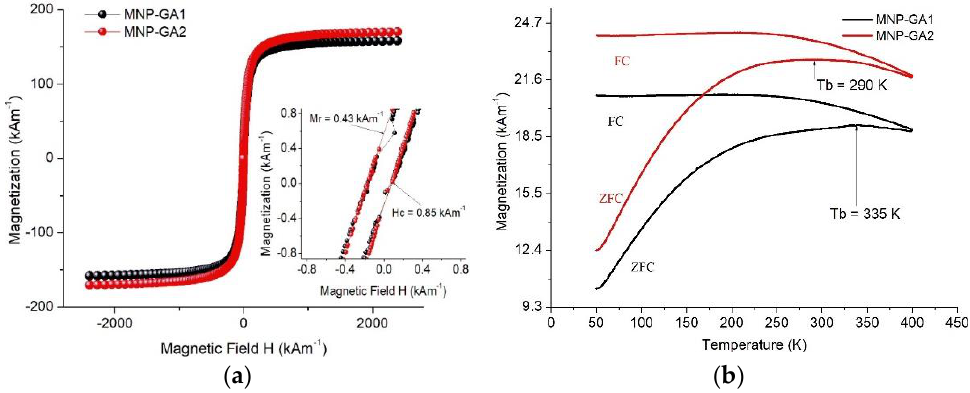
Figure 6. ( a ). The magnetization loop of the coated samples at room temperature, over the interval − 2387 kAm −1 < H < 2387 kAm −1 including an inset plot. ( b ) Magnetization following the ZFC-FC trace − 2387 kAm − 1 < H < 2387 kAm − 1 including an inset plot. ( b ) Magnetization following the ZFC-FC with H = 7.96 kAm −1 over the interval from 50 K to 400 K. trace with H = 7.96 kAm − 1 over the interval from 50 K to 400